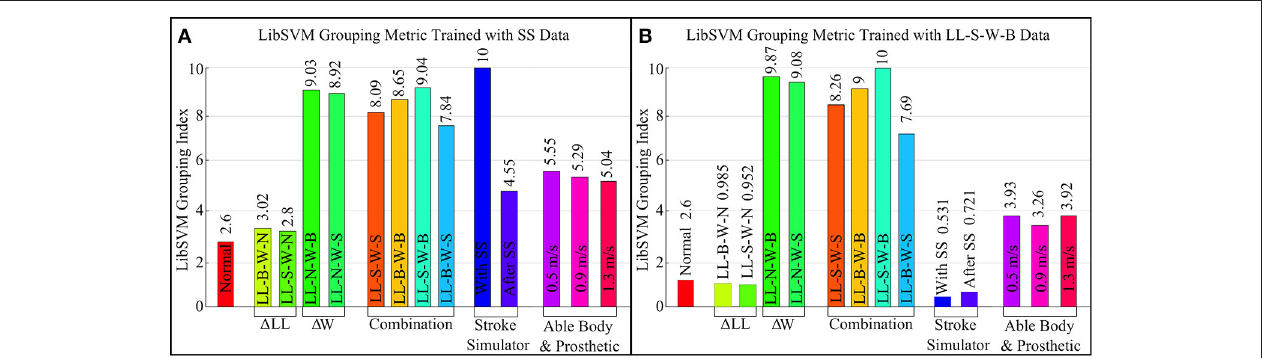
FIGURE 7 | Machine learning (LibSVM) grouping metric using two different datasets for training. (A) Uses the asymmetry data for walking with stroke simulator. (B) Uses the LL-S-W-B data which was found to have the largest CGAM score notice the differences in